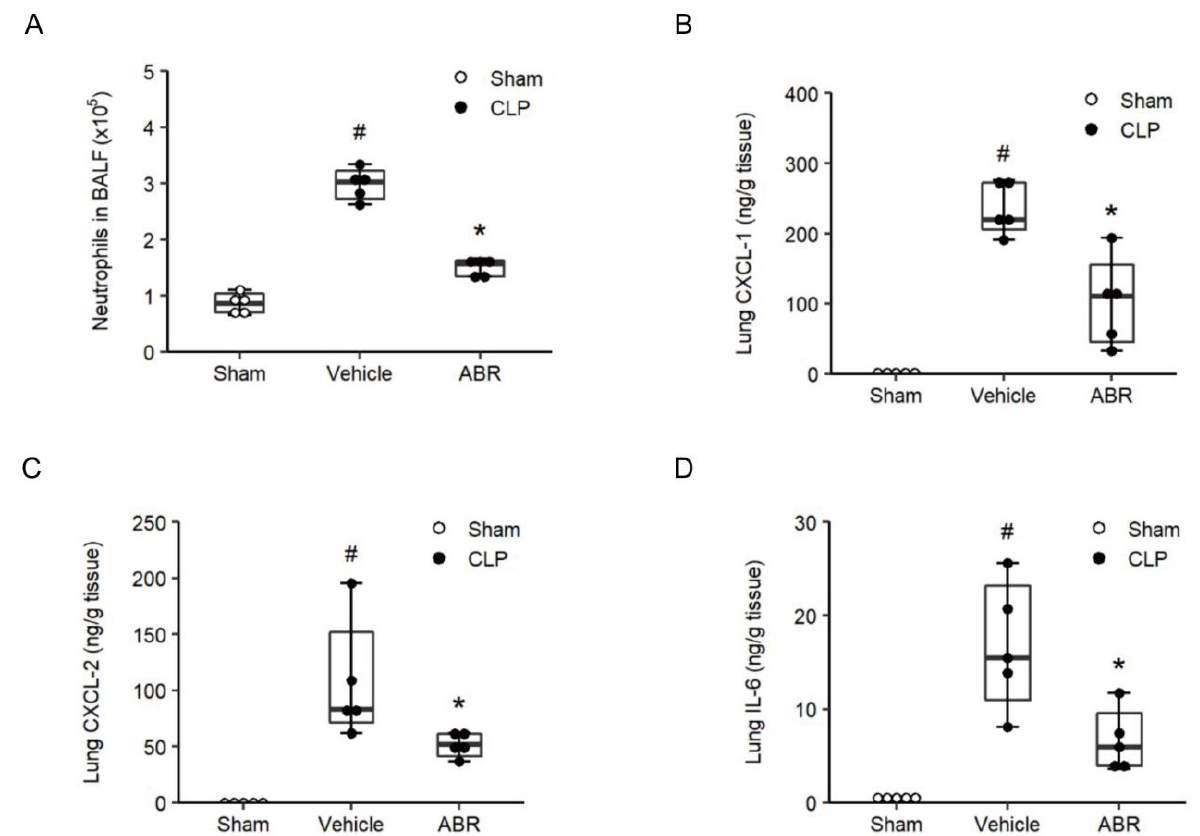
Figure 3. S100A9 regulates neutrophil recruitment. ( A ) BALF neutrophils were quantified in Bronchoalveolar lavage fluid (BALF) collected 24 h after CLP induction. Levels of ( B ) CXCL-1, ( C ) CXCL-2 and ( D ) IL-6 in the lungs were determined